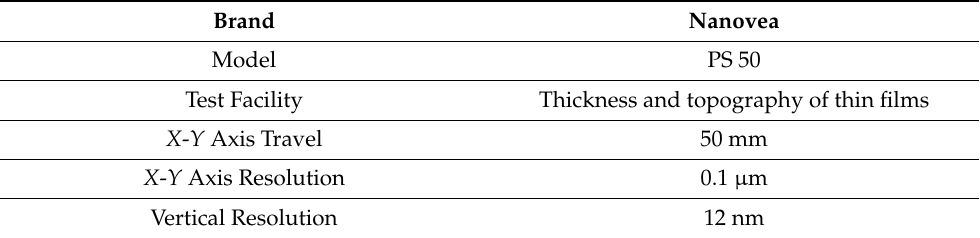
Table 6. Optical profilometer specification.